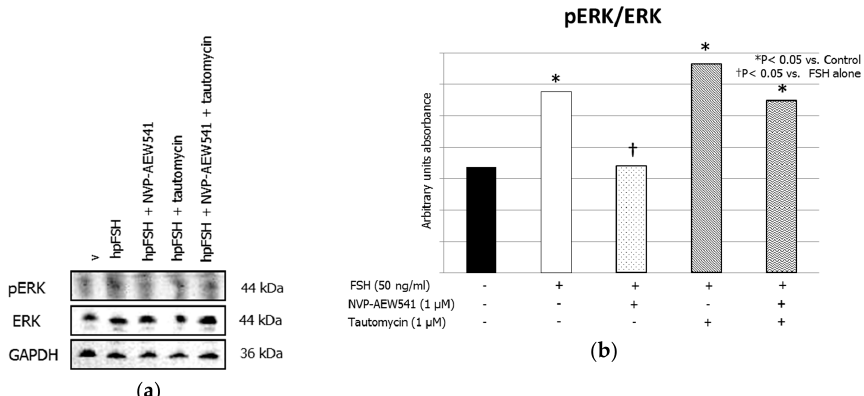
Figure 2. IGF1R is required for the FSH-induced extracellular-signal-regulated kinase (ERK) 1/2 phosphorylation. ( a ) Immunoblots and ( b ) densitometric analysis of the protein bands of pERK1/2, ERK1/2 and Glyceraldehyde-3-Phosphate Dehydrogenase (GADPH) from SCs alone (control) or incubated with hpFSH alone or pre-treated with the IGF1R inhibitor NVP-AEW541 and/or PP1ß inhibitor tautomycin and then incubated with hpFSH. Data represent the mean ± SEM (* p < 0.05 vs. controls and † p < 0.05 vs. FSH treatment alone) (one-way ANOVA) of three independent experiments, each performed in triplicate.